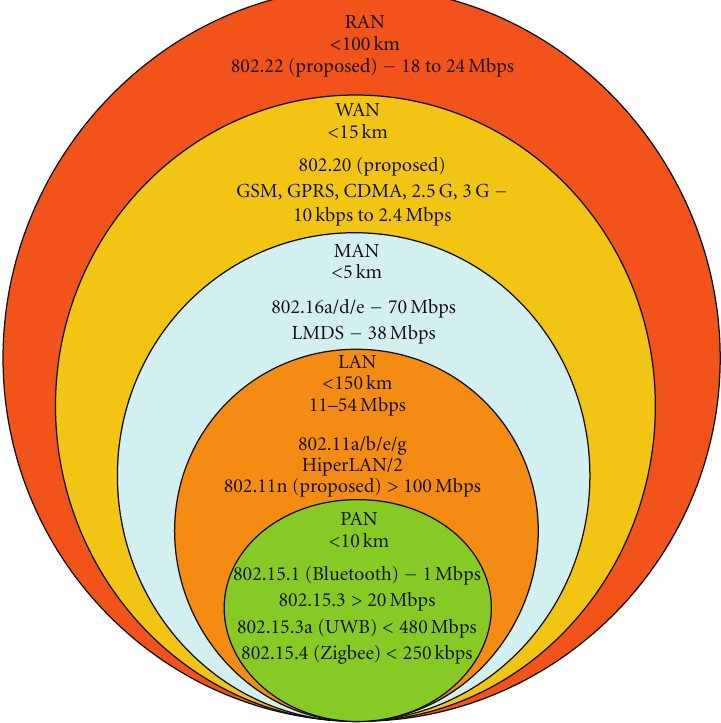
Figure 1: Comparison of 802.22 with other wireless